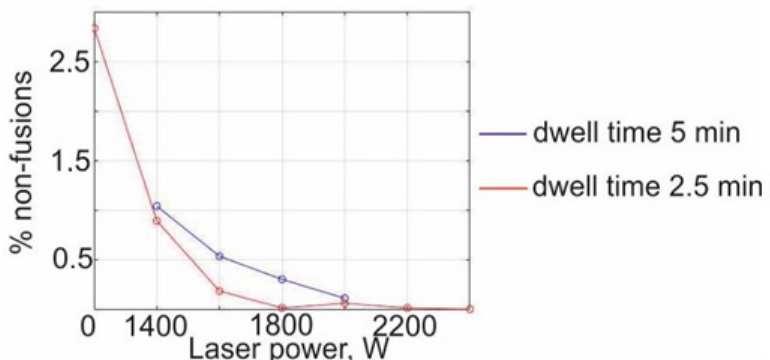
Figure 8. The non-fusion percentage dependence on the power of laser